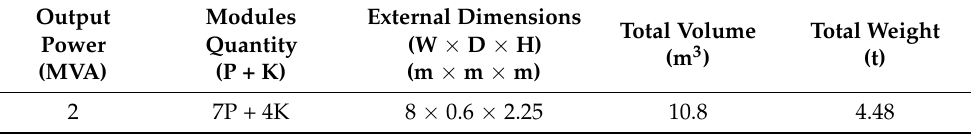
Table 11. Required assembly parameters of the AC/DC converter.